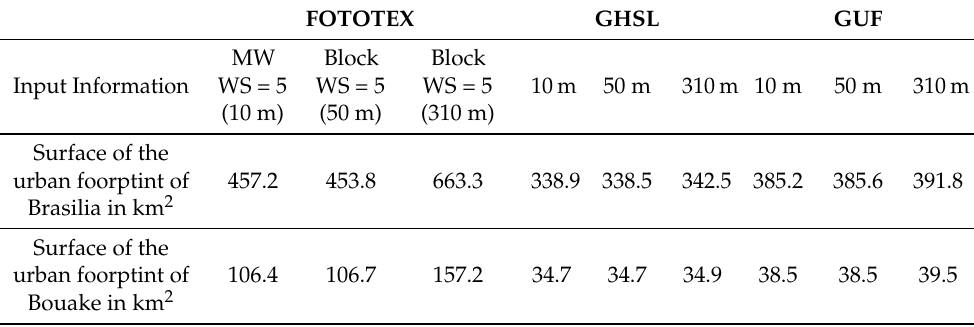
Table 3. Surface of the urban footprints of Brasilia and Bouake from FOTOTEX using Sentinel 2 images under various configurations, and comparison with the Global Human Settlement Layer (GHSL) product (from JRC) and the Global Urban Footprint (GUF) product (from German Aerospace Center DLR) on both areas (PX =pixel size, WS = window size, PM = partitioning method, MW = Moving Window, DC = DC component, N = normalize). FOTOTEX GHSL